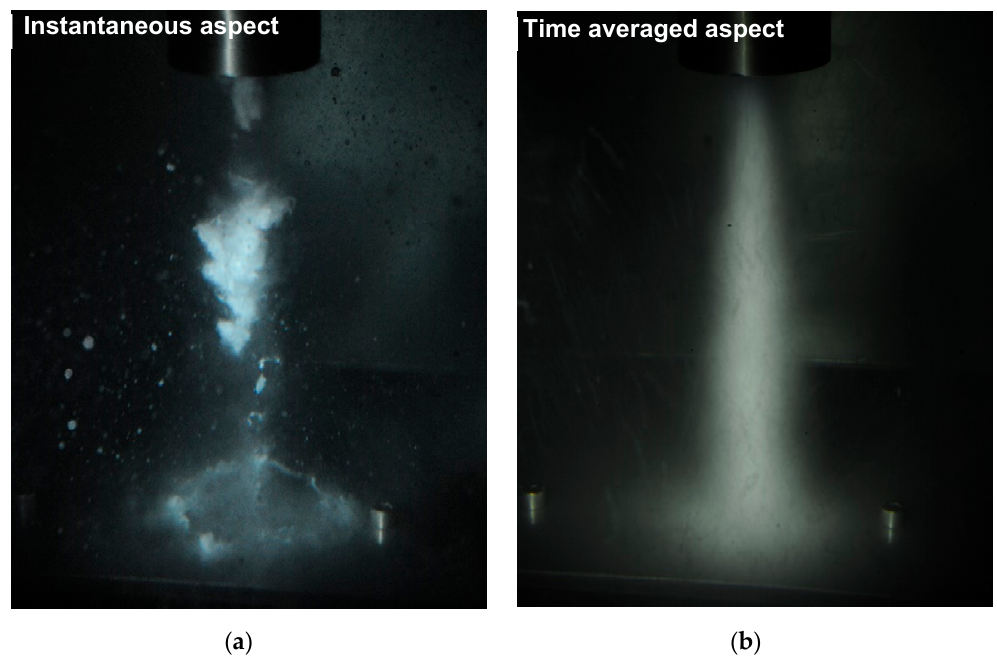
Figure 4. Aspects of cavitating jet (cylindrical nozzle, nozzle diameter d = 2 mm, upstream pressure p 1 = 30 MPa, downstream pressure p 2 = 0.1 MPa, standoff distance s = 222 mm): ( a ) observation with flash lamp whose exposure time is 1.1 µs; ( b ) observation with normal light and shutter speed of 40 ms.